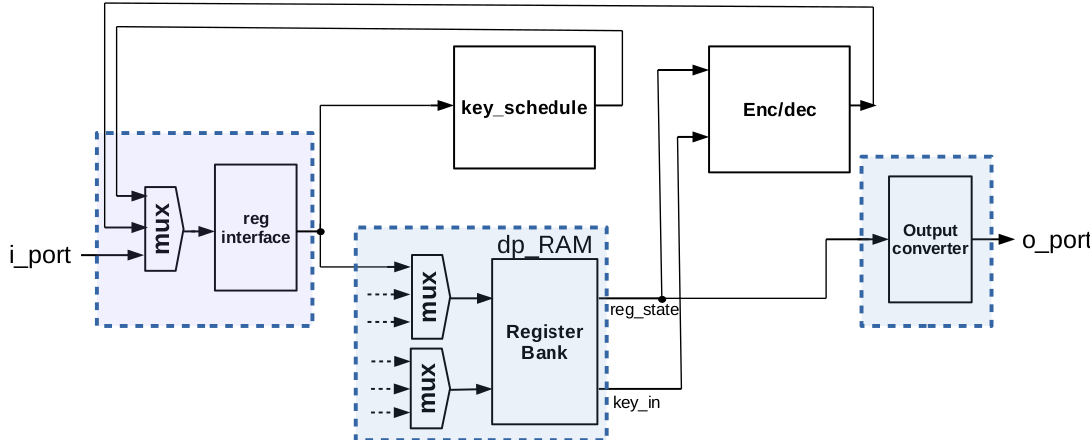
Figure 4. Blocks providing AES-128 support in the ECC163AES128